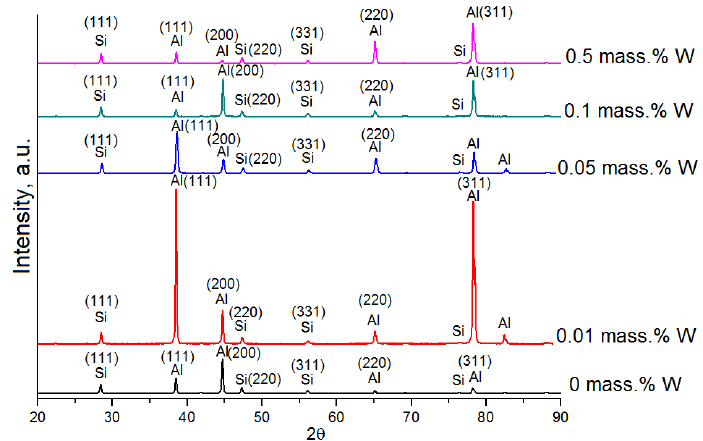
Figure 4. X-ray diffraction patterns of Al-12%Si alloys with different contents of W.